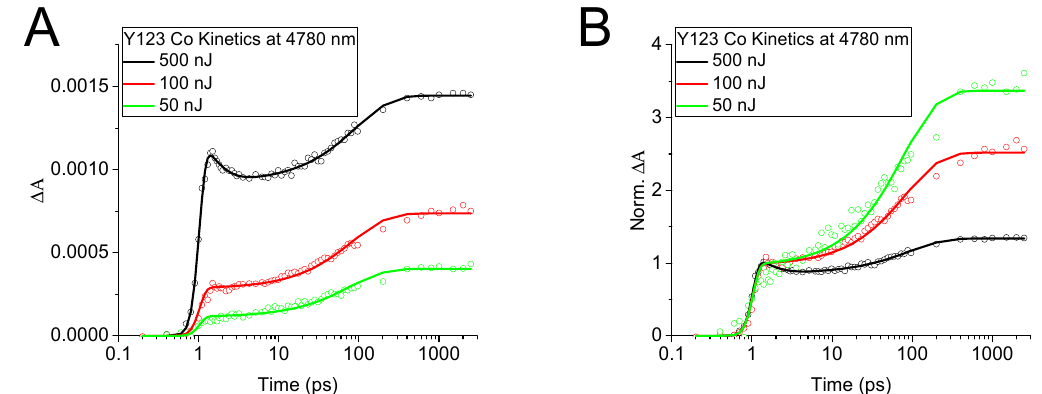
Figure 3. Kinetic traces at 4780 nm for Y123 samples cells with sapphire substrate at different pump intensity (points) with the fitted function (solid lines) ( A ) as measured and ( B ) normalized. The time zero was shifted to 1 ps in order to present the time axis in logarithmic scale. The parameters of the fits are given in Supplementary Table S2.